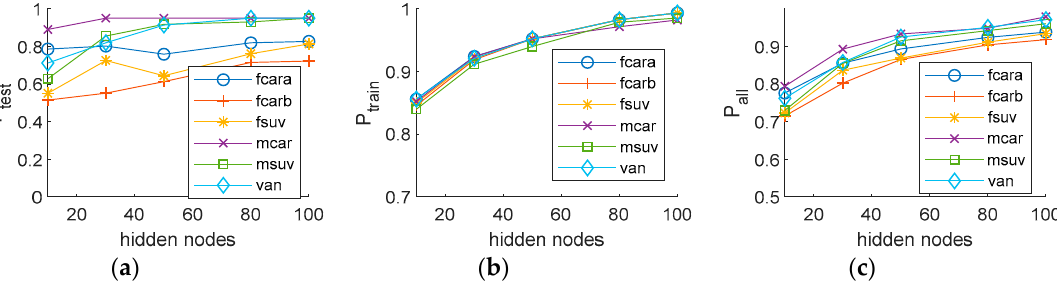
Figure 10. The accuracy of each model changing with training set ratio β . The horizontal axis in the figure represents the proportion of the number of training images to the total number of images. The vertical axis represents the recognition accuracy: ( a ) The accuracy of the test set; ( b ) The accuracy of the training set; ( c ) The accuracy of all images.